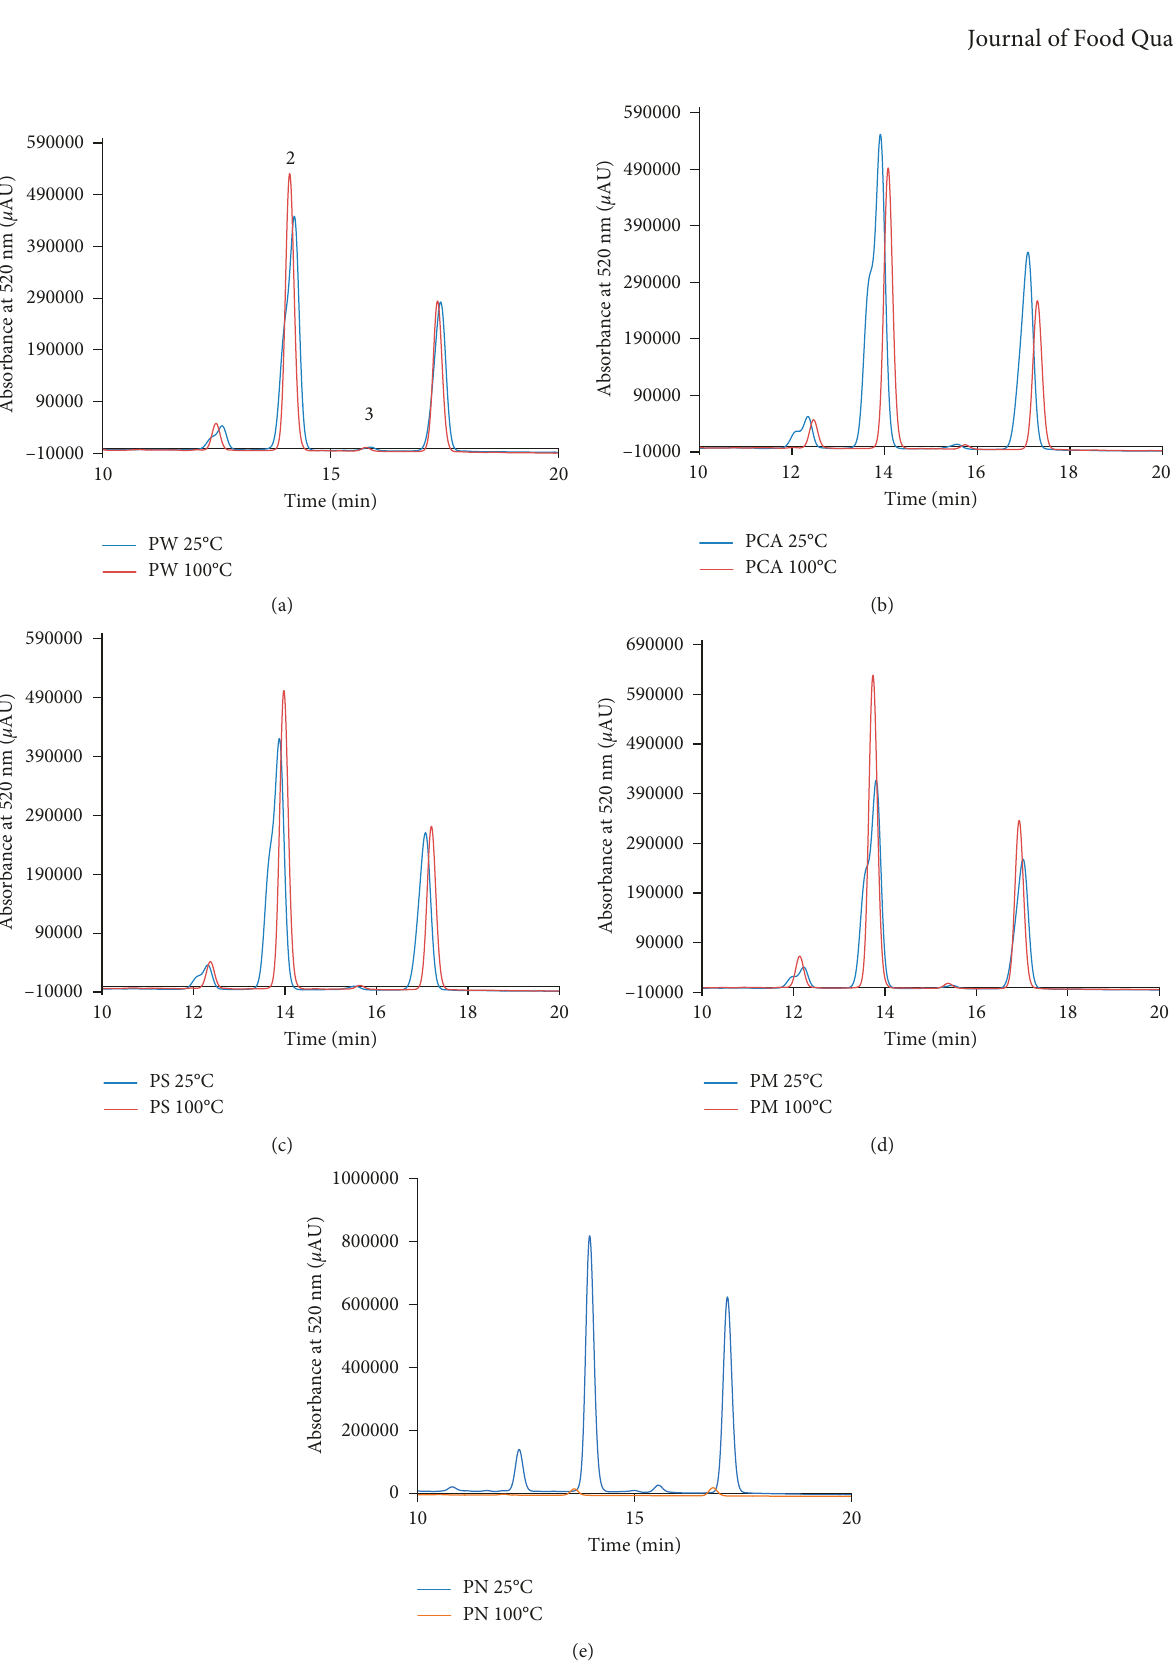
Figure 1: HPLC chromatogram of plum anthocyanins at 25 ° C and after 20 minutes of treatment at 100 ° C from (a) plum juice with water (PW), (b) plum juice with citric acid (PCA), (c) plum juice with sugars (PS), (d) plum juice with mixture (PM), and (e) natural plum juice (PN) at 520nm. For PW, PCA, PS, and PM, peaks represent (1) cyanidin 3-glucoside; (2) cyanidin 3-rutinoside; (3) peonidin 3-glucoside; (4) peonidin 3-rutinoside. Peak assignments are given in Table